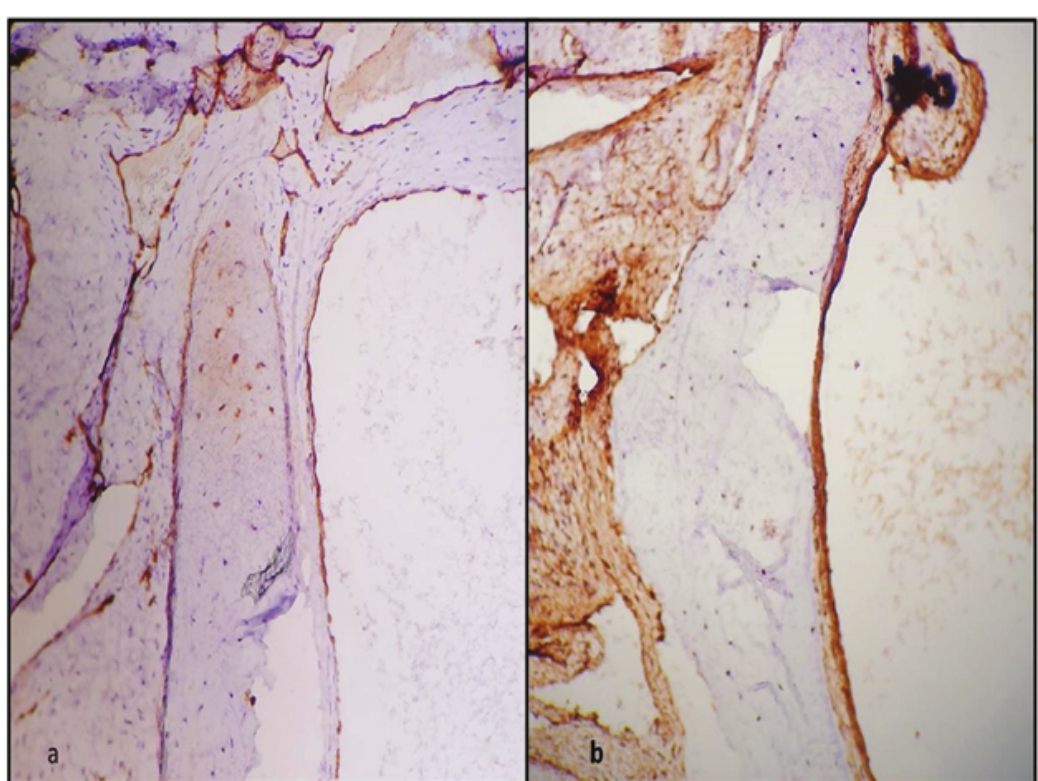
Figure 3 : Immunohistochemical study. (a) CD34-positive endothelial cells (X20) (b) Smooth muscle actin (SMA)-positive endothelial cells of blood vessels and spindle cells